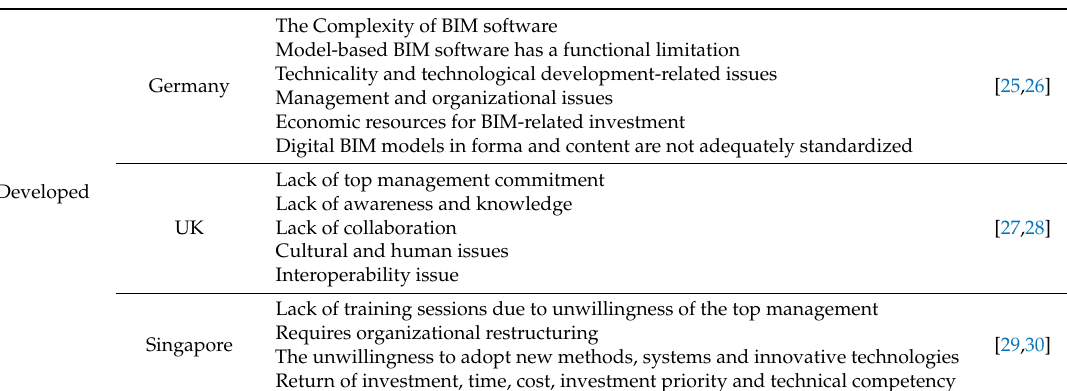
Table 5. Barriers in various